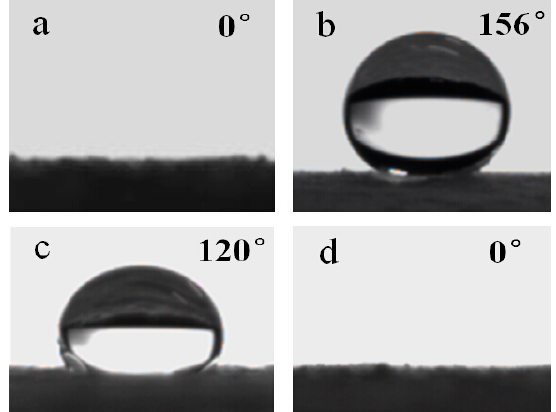
Figure 3. Images of a liquid droplet on different surfaces: typical photograph of a 5 μ L water droplet on the surfaces of ( a ) pristine wood flour and ( b ) superhydrophobic/superoleophilic wood flour; ( c ) a water droplet on a wood flour surface treated with octadecanoic acid; ( d ) an oil droplet on a superhydrophobic/superoleophilic wood flour surface.